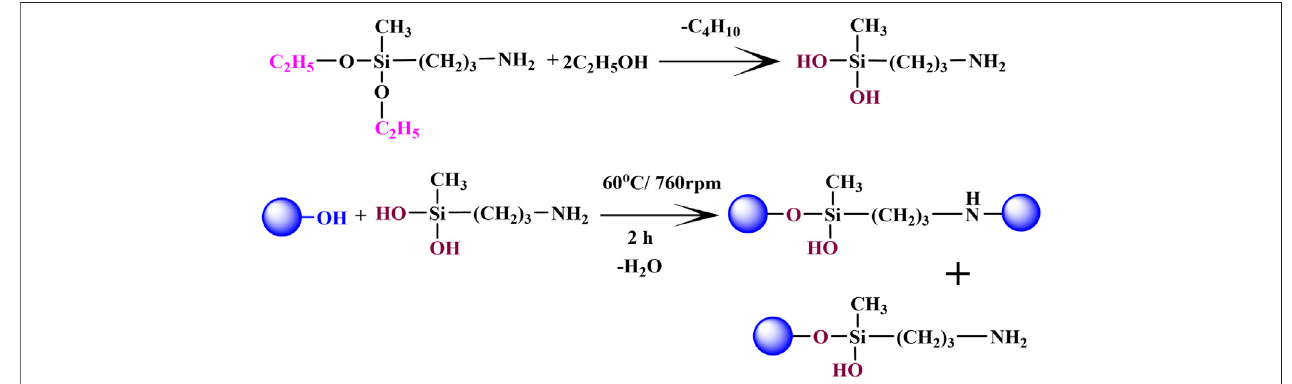
FIGURE 9 | Proposed reaction for modi fi cation of sepiolite with 3-APDEMS